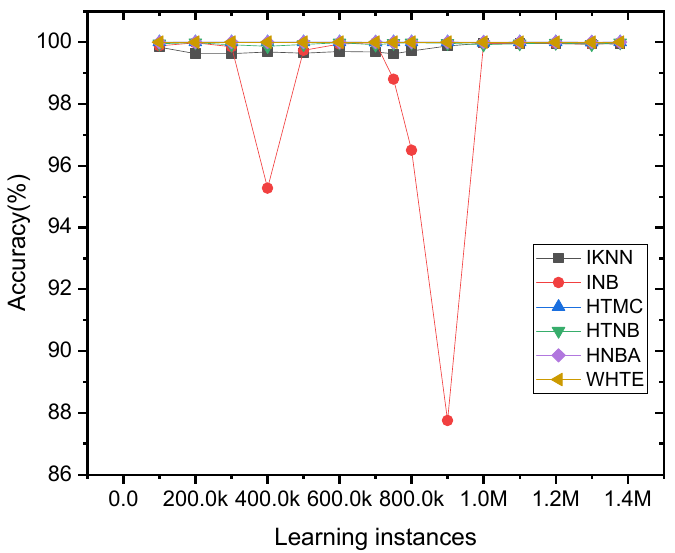
Figure 11. The incremental accuracy of the applied methods per 5K sliding window samples for the NetFlow-ToNIoT dataset. For clear visualization, the accuracy was averaged for every 100K samples.